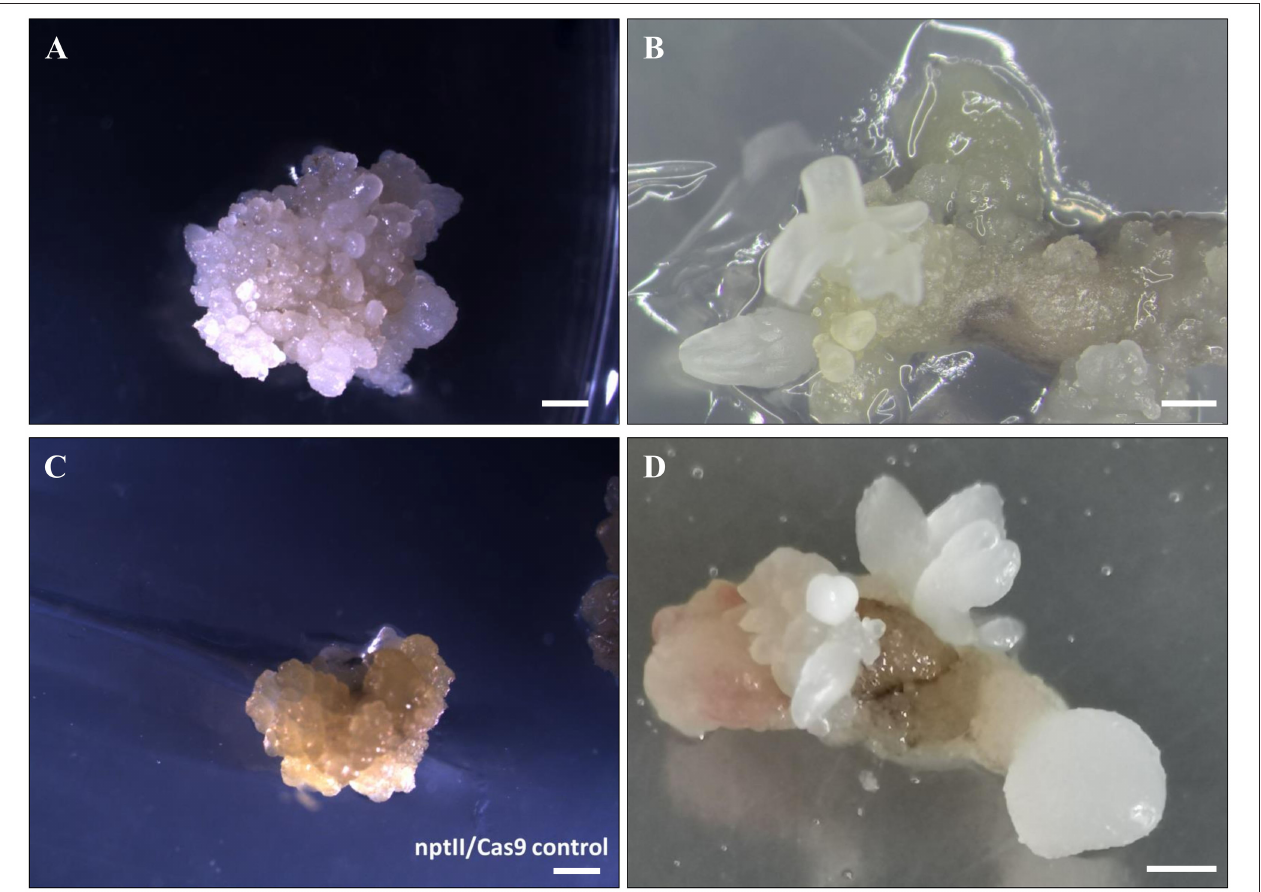
FIGURE 3 | Gene editing of somatic embryos of European chestnut. (A,B) White transgenic somatic embryos at different developmental stages formed after 12 weeks on selection medium. (C) nptII/Cas9 control. (D) Secondary embryos of W1 line generated following 6 weeks of culture on selection medium. Bar: